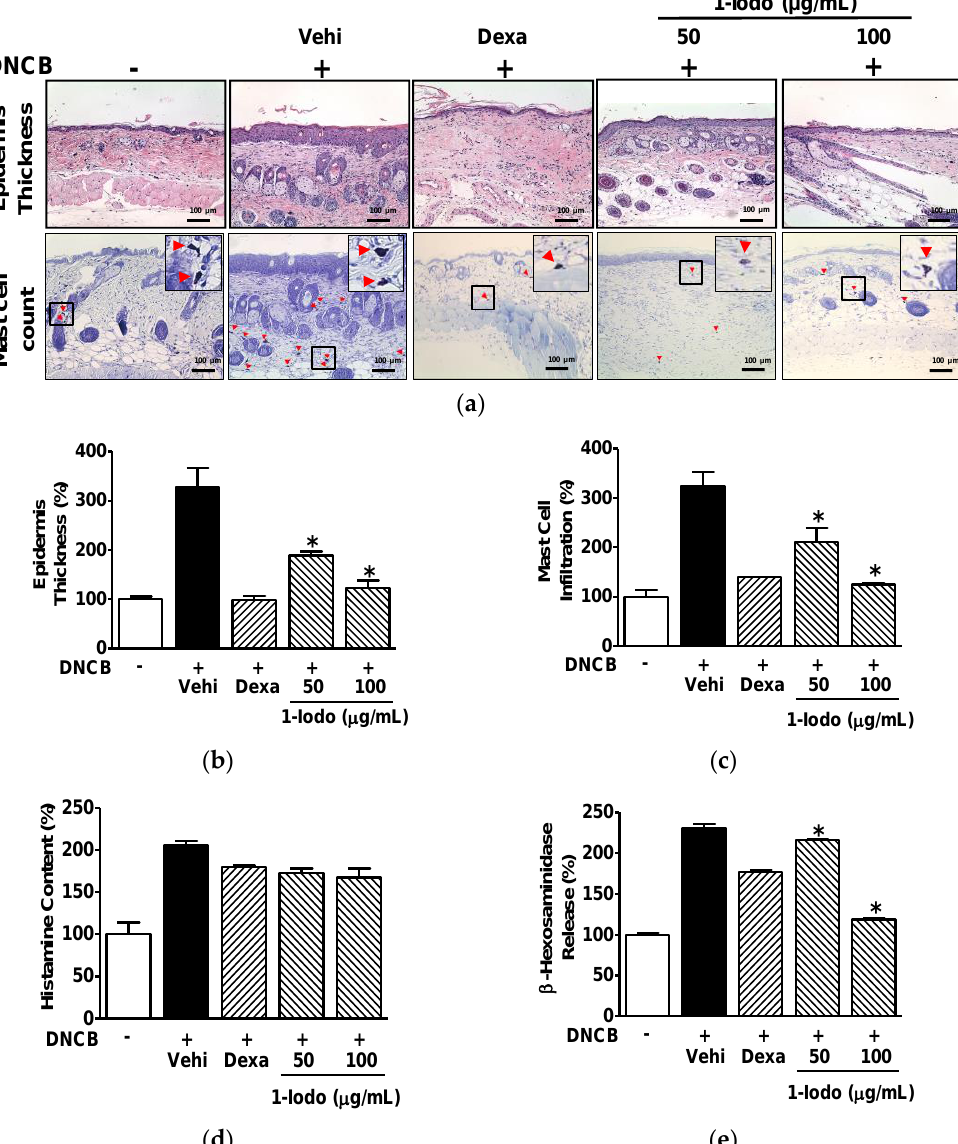
Figure 5. Histopathological features of skin lesions and serum levels of mast cell degranulation markers in DNCB-induced mouse model treated with 1-iodohexadecane. The dorsal skins of mice were treated with 2,4-dinitrochlorobenzene (DNCB) with or without 1-iodohexadecane (1-Iodo; 50 or 100 μg/mL) for 21 days. The skin tissues were excised, fixed with 4% formaldehyde, embedded in paraffin, and sectioned as described in the Materials and Methods section. The blood was collected and centrifuged to obtain the serum as described in the Materials and Methods section. ( a ) Representative histological images. Sections were stained with H&E for epidermal thickness measurements or toluidine blue for mast cell counting. Red arrowheads indicate mast cells stained with toluidine. Scale bar = 100 μm. ( b , c ) Graphs of the results shown in panel ( a ). The epidermal thickness (upper images of panel ( a ), n = 3) and mast cell infiltration (lower images of panel ( a ), n = 3) were measured using Image J software. ( d , e ) Serum levels of histamine and β -hexosaminidase. Levels of histamine ( d ; n = 2) and β -hexosaminidase ( e ; n = 2) in the obtained sera were measured using an enzyme immunoassay. Dexamethasone (Dexa, 0.1%) in each test was used as a positive control. Values are expressed as percentages of those of non-treated controls. The results are presented as means ± SEMs. * p < 0.05 versus DNCB controls. Vehi, vehicle (100% olive oil). In addition, to determine whether 1-Iodo influences mast cell degranulation markers in vivo , we assessed histamine and β -hexosaminidase levels in the serum of DNCB-in- duced mice model treated with 1-Iodo. DNCB elevated histamine levels (205.36 ± 5.48%